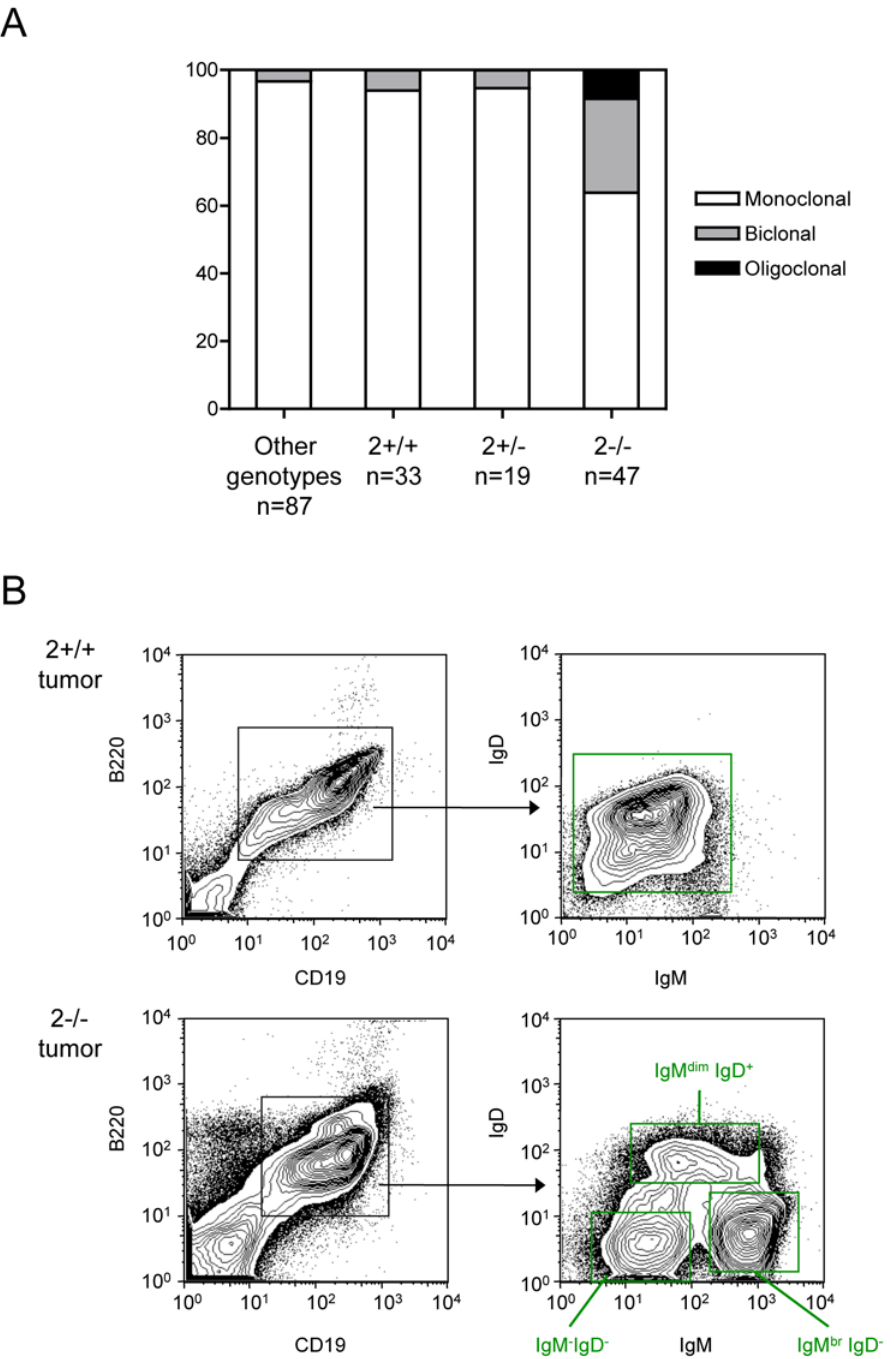
Figure 5. Analysis of E2F2 cohort lymphomas shows that some E2f2 -null E m - myc transgenic tumors are polyclonal. (A) The clonality of lymphomas as indicated by the pattern of immunoglobulin heavy chain rearrangements in Southern blotting. Lymphomas were characterized as monoclonal if there were zero, one, or two bands in addition to the residual genomic band, as biclonal if there were three or four bands in addition to the genomic band, and as oligoclonal if there were five or more bands in addition to the genomic band. (B) Flow cytometric analysis of lymphomas. Top panels, an E2f2 + / + E m - myc transgenic lymphoma and bottom panels, an E2f2 2 / 2 E m - myc transgenic lymphoma. The tumor cells were stained to identify mature B cell subsets defined by B220 and CD19 and surface expression of IgM and